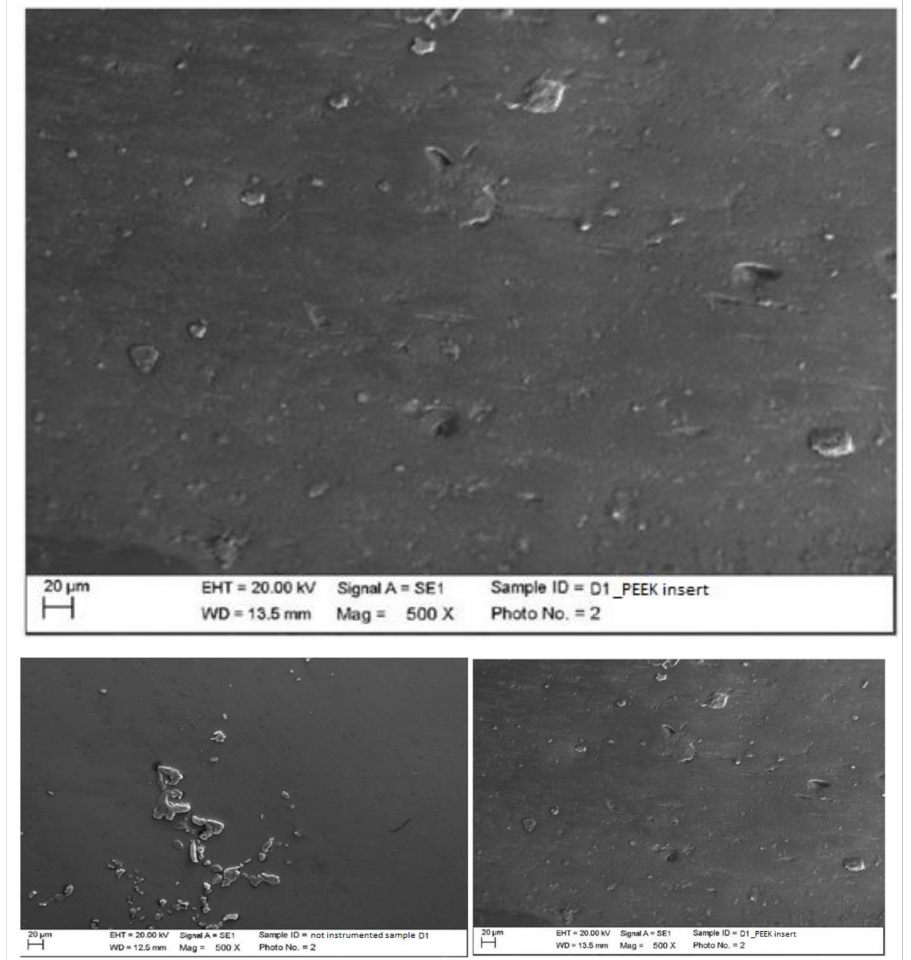
Figure 11. Instrumented disilicate sample D1 with peek insert (500 × ). Comparison before/after instrumentation.